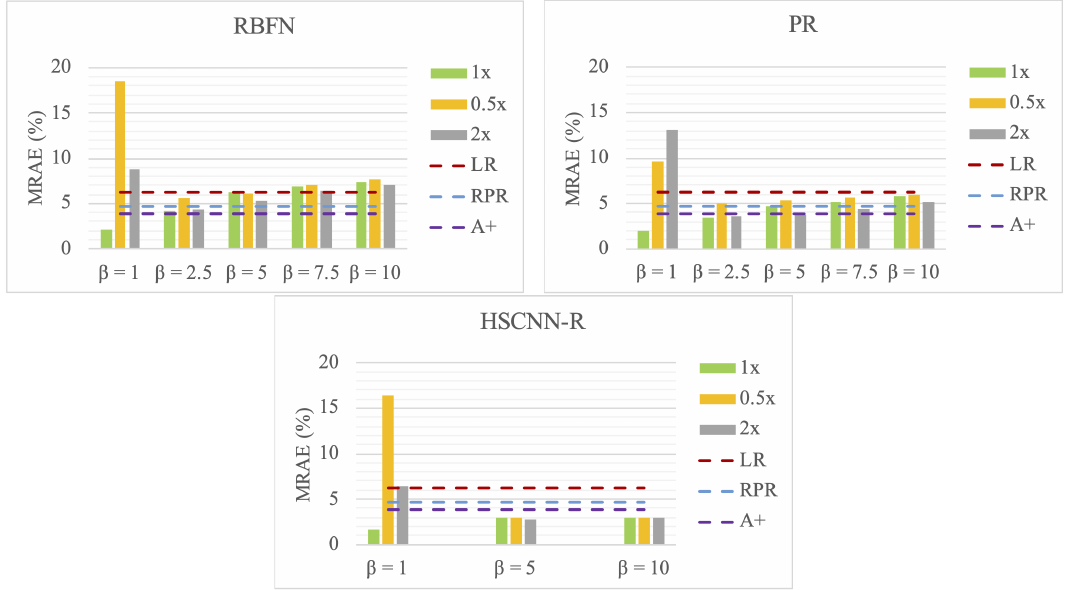
Figure 10. Visualizing the performance and generalizability (in mean MRAE) with respect to different β factors